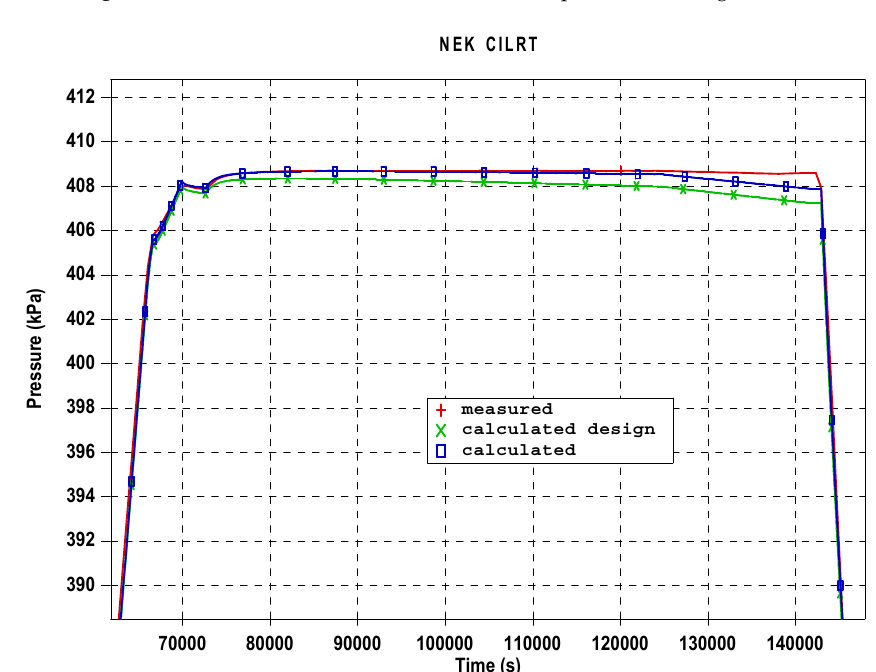
Figure 4. Decrease of the containment pressure due to leakage in the testing phase.